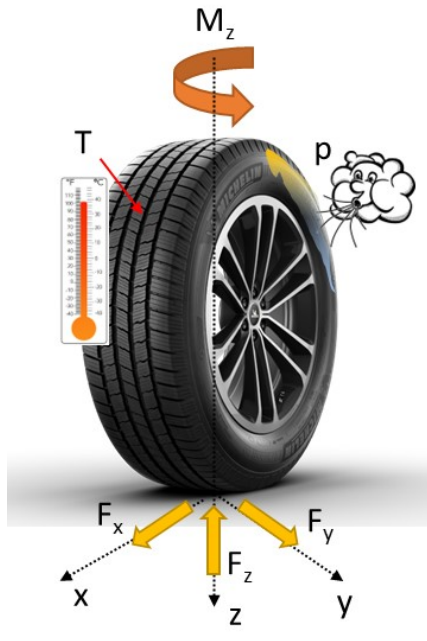
Figure 8. Measured quantities.